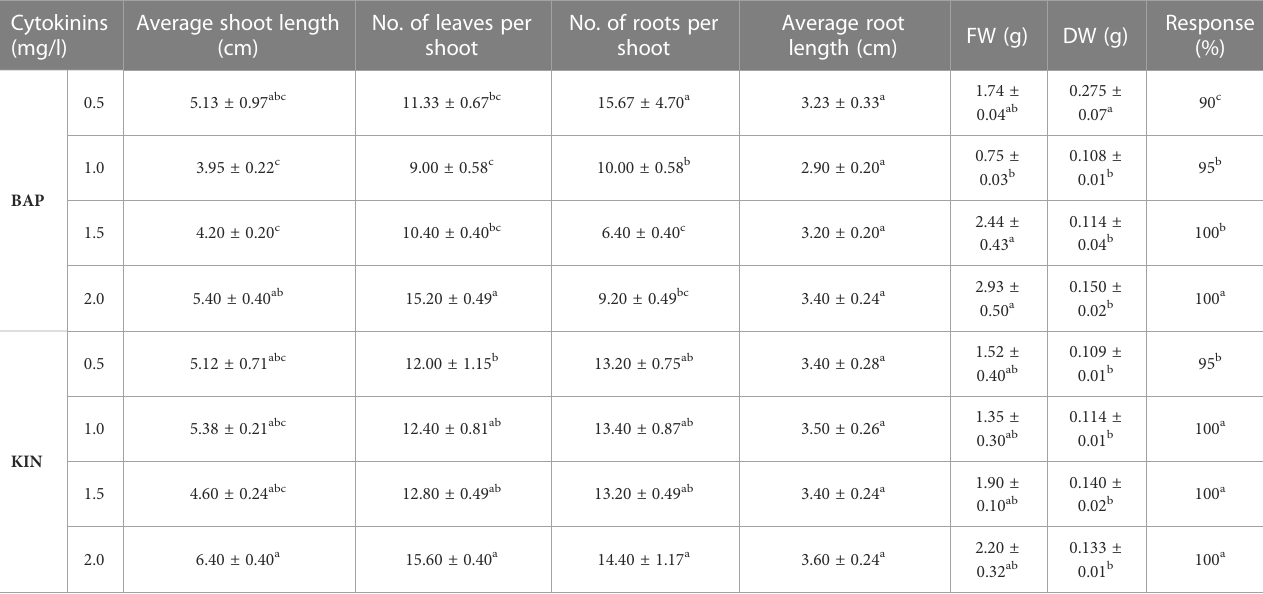
TABLE 1 Effect of cytokinins (BAP and KIN) on regeneration of Bacopa fl oribunda . Cytokinins (mg/l)